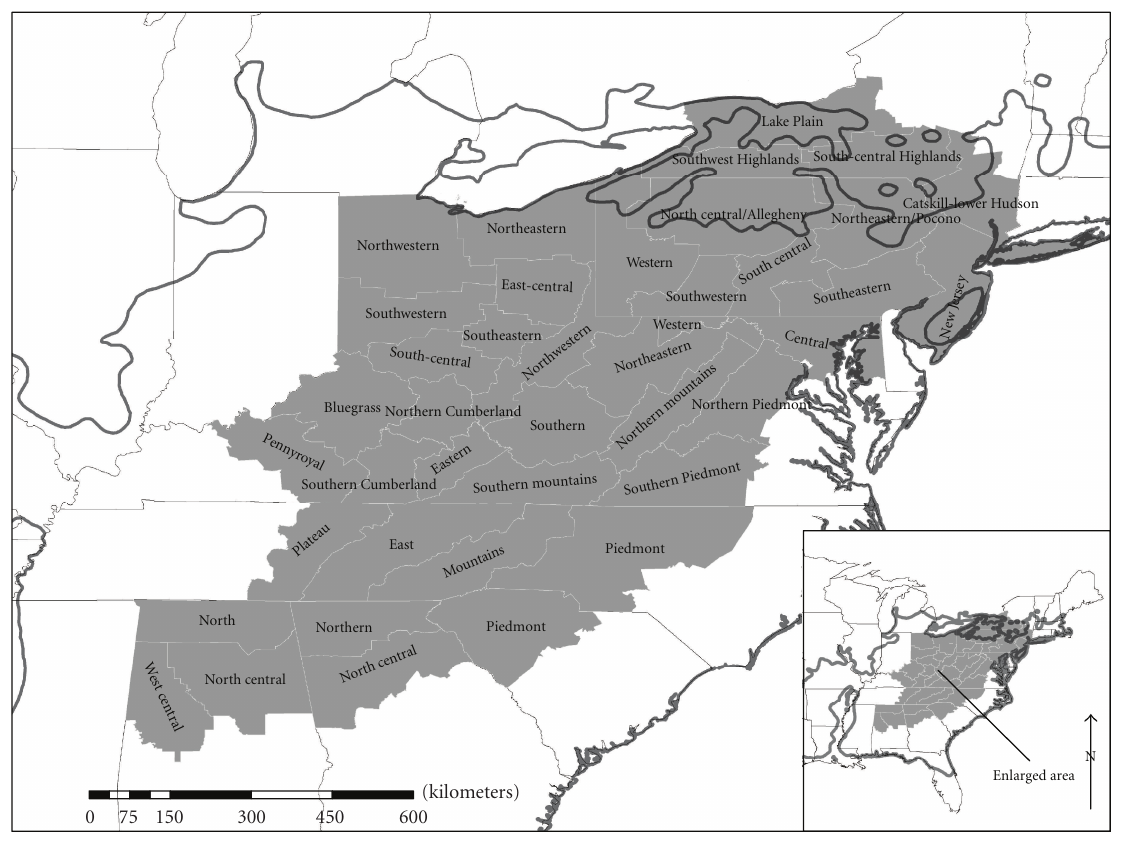
Figure 1: The Appalachian ecoregion and associated FIA unit boundaries.